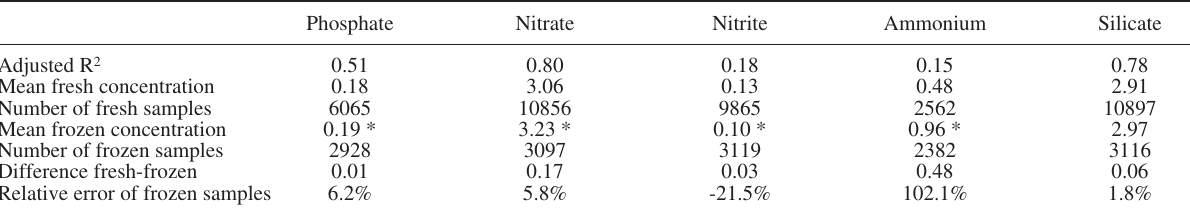
Table 6. – Summary of the results on the freezing effect on seawater nutrient concentration ( mM ) using the data of the cruises collected. P -value for all adjusted r 2 <0.01. * indicates the existence of statistically significant differences ( P <0.01) between the mean concentration of freshly (on board) analyzed samples and frozen nutrient samples. Nitrate average from frozen samples does not include 19 values higher than 15 m M from the “Hivern 1999” cruise.